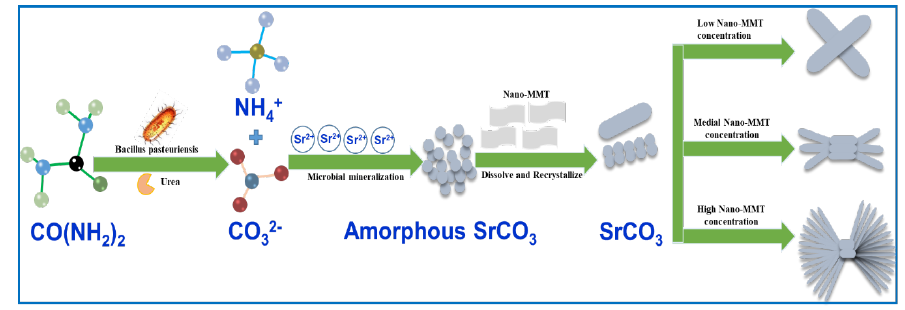
Scheme 1. Formation of flower-like with superstructure SrCO 3 in the presence of nano-MMT.